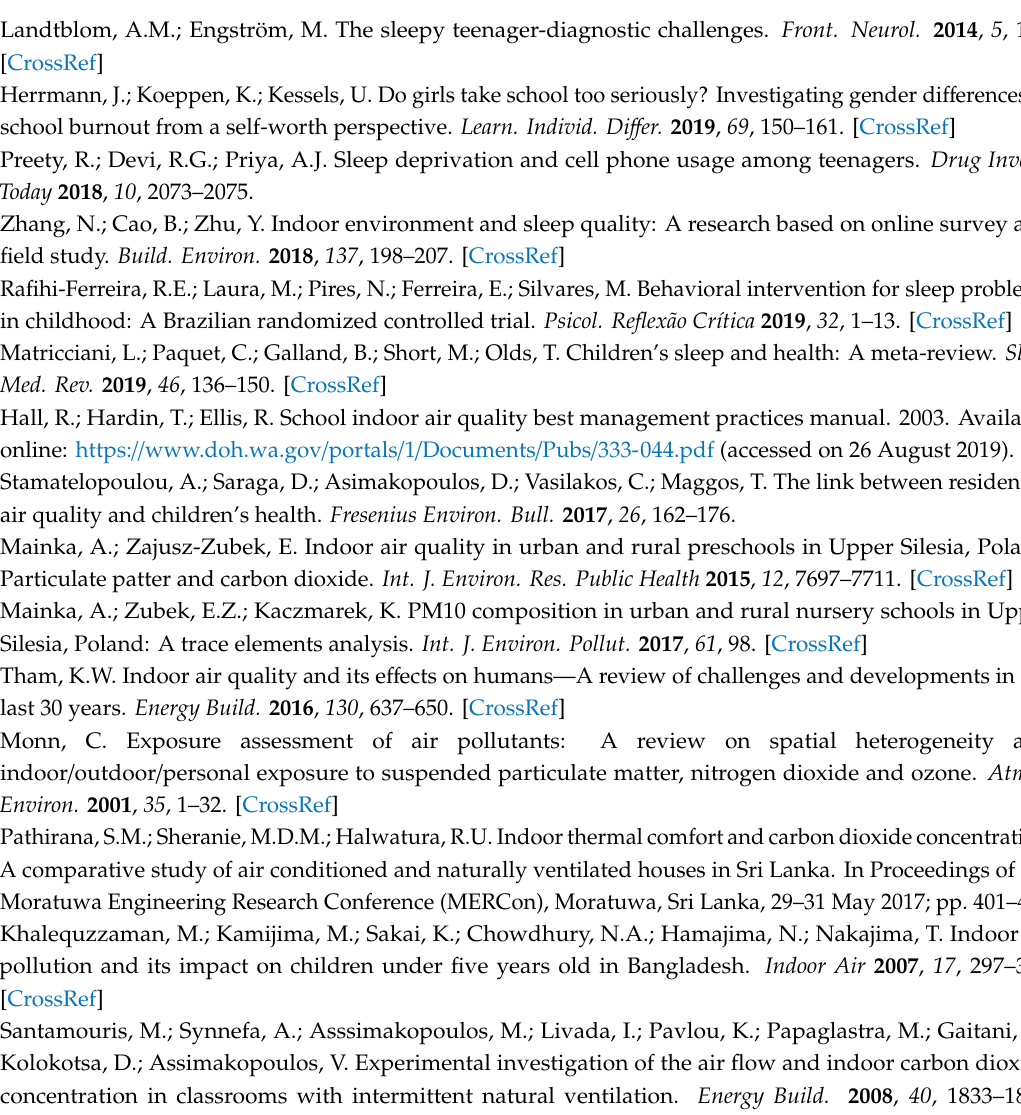
Table S1: General characteristic of studied bedrooms as well as the distribution of nightly average indoor temperature and humidity in each studied bedroom depending on door